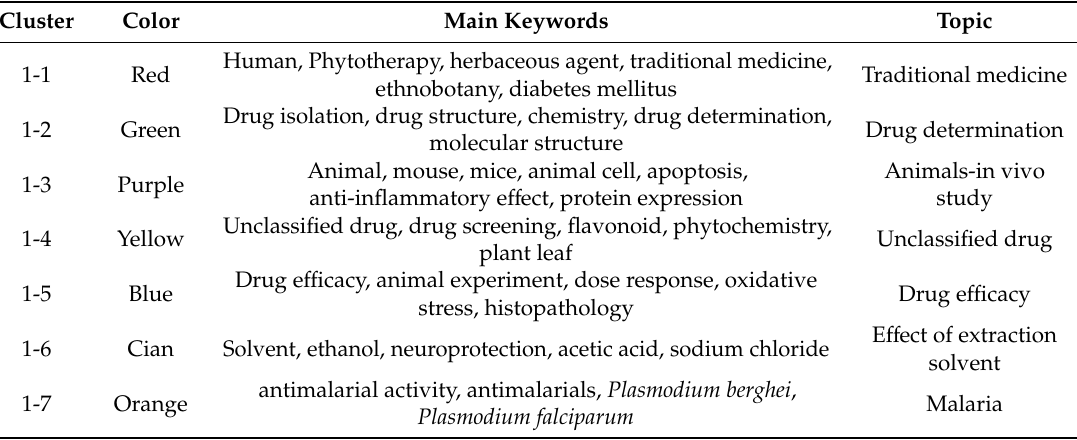
Figure 9. Network of keywords in medical plants publications: Clusters between 2009–2014. Figure 9 . Network of keywords in medical plants publications: Clusters between 2009 – 2014 . Table 6. Main keywords used by the communities detected in the topic in the period